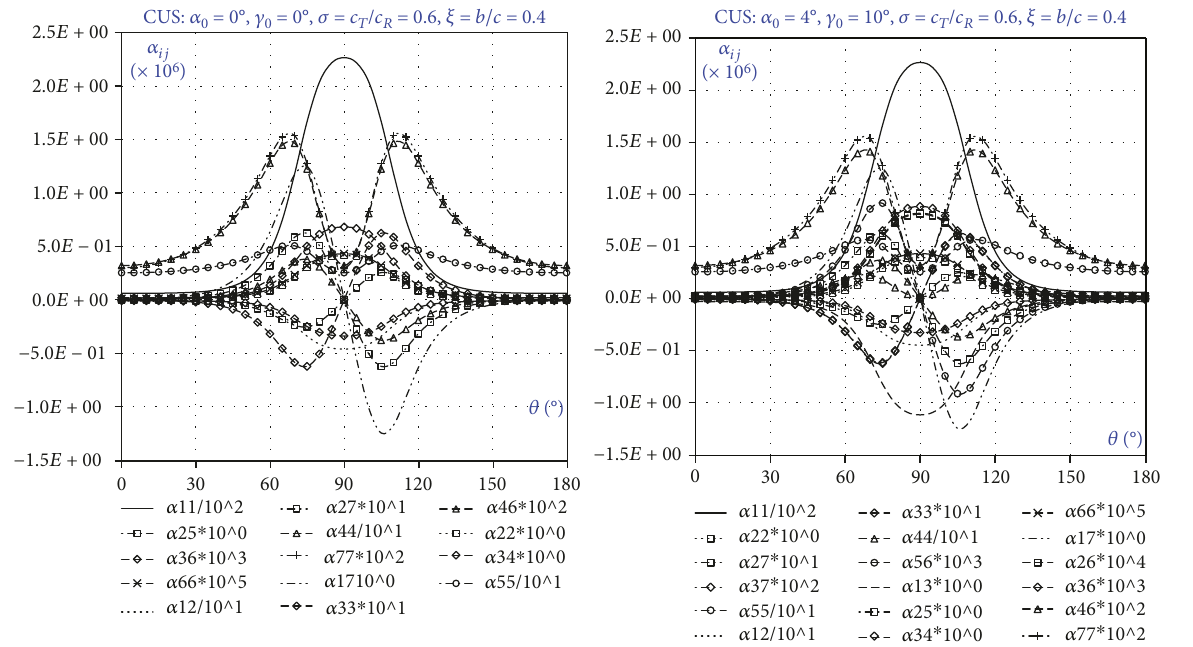
= a ij ji vs. ply angle of Model A for CUS.